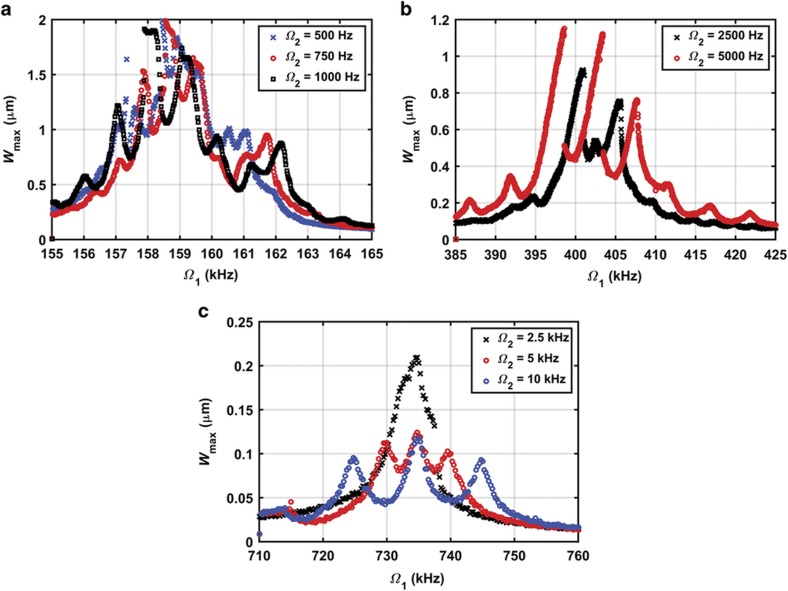
Frequency response curves for different values of Ω2. (a) Near the first mode at VDC=15 V, VAC1=5 V, and VAC2=35 V. (b) Near the second mode at VDC=15 V, VAC1=20 V, and VAC2=70 V. (c) Near the third mode at VDC=20 V, VAC1=40 V, and VAC2=20 V.